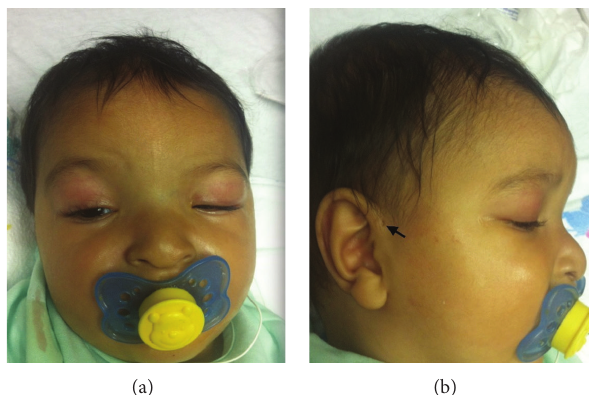
Figure 1: Clinical presentation of CES: (a) hypertelorism with facial asymmetry and (b) preauricular pit (arrow).